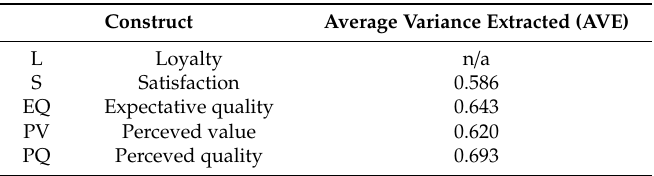
Table 7. Average variance extracted.